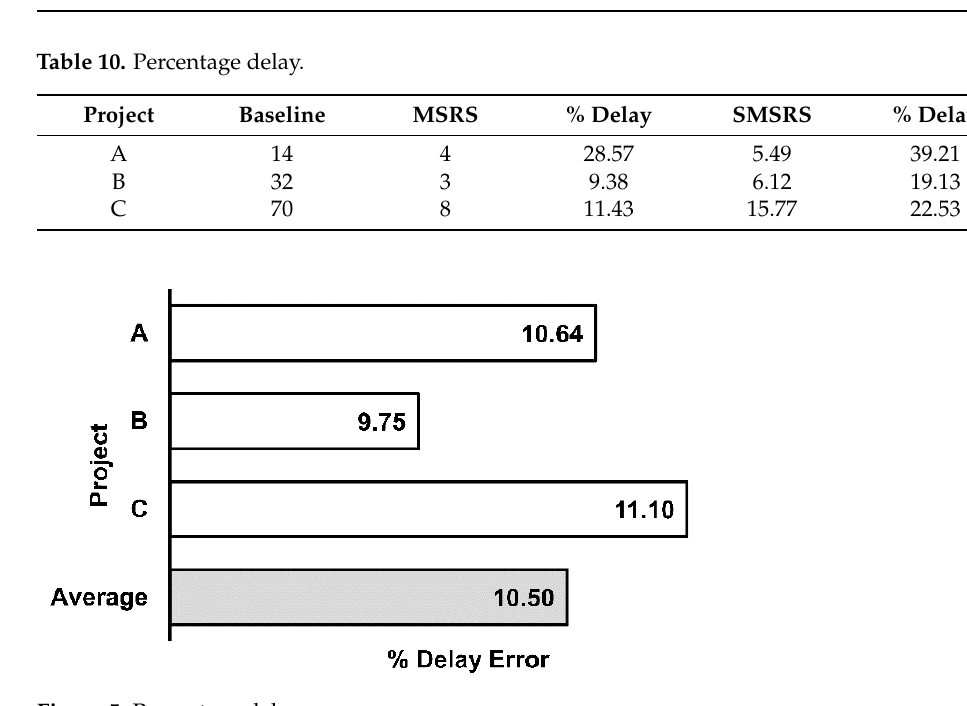
Figure 5. Percentage delay error.